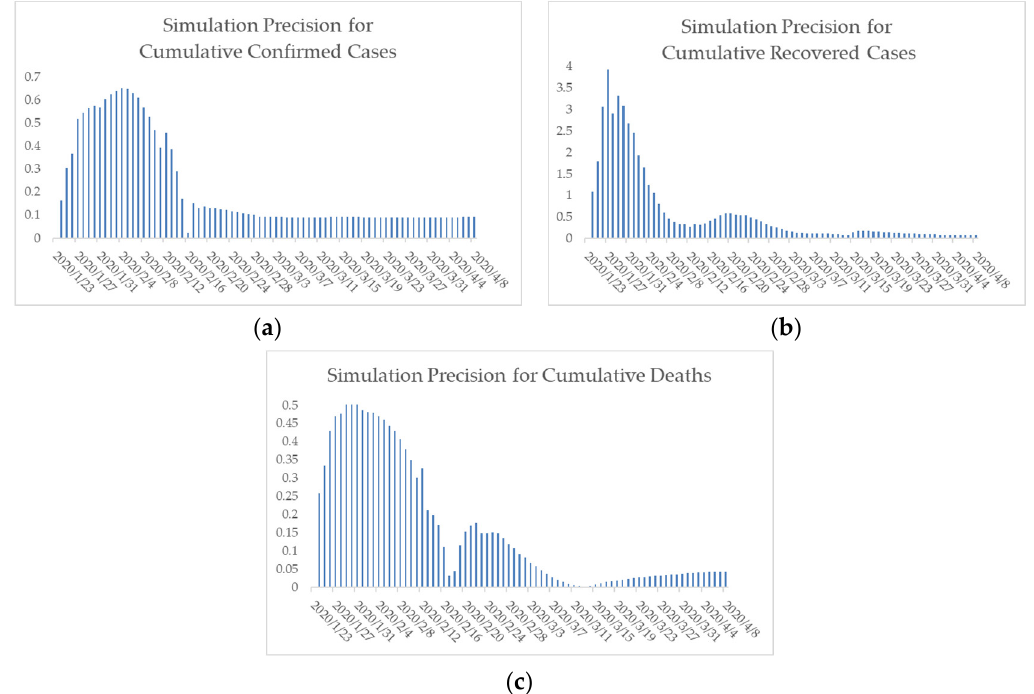
Figure 8. Epidemic cumulative cases simulation precision from 23 January 2020 to 8 April 2020. ( a ) Simulation precision for cumulative confirmed cases; ( b ) simulation precision for cumulative recovered cases; ( c ) simulation precision for cumulative deaths.